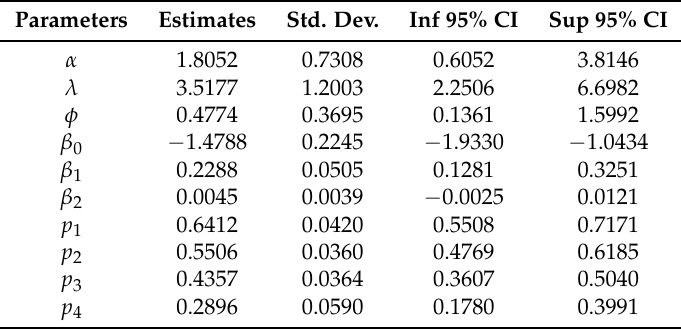
Table 3. MLEs of the Bernoulli Kumaraswamy Exponential model for the melanoma data set. Parameters Estimates